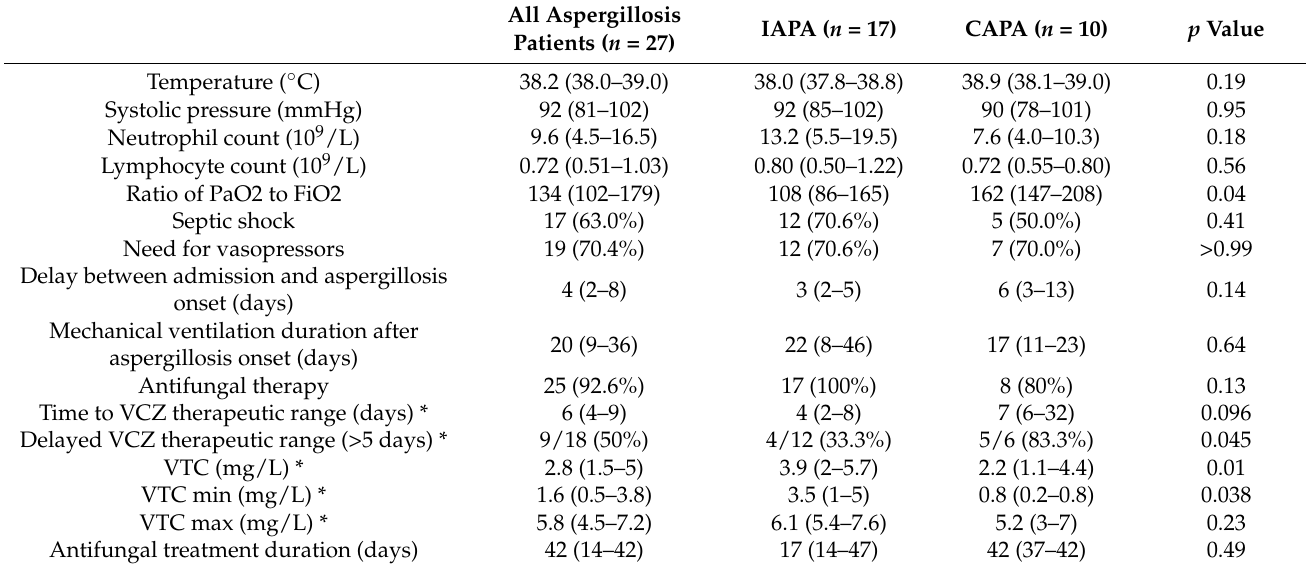
Table 2. Clinical and biological characteristics at CAPA and IAPA diagnosis.